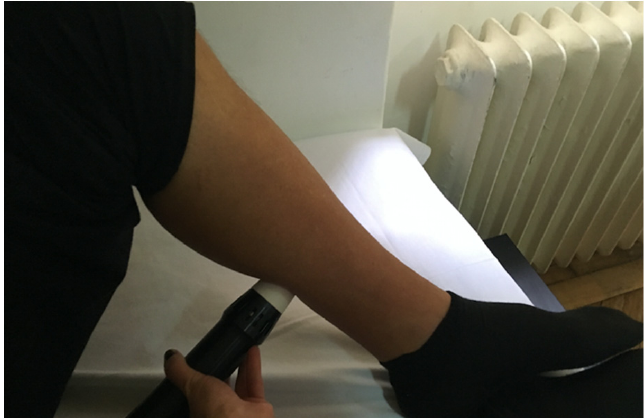
Figure 1. Radial extracorporeal shock wave therapy delivery on a patient from the clinical trial; original picture taken by the author EE Mihai in the Department of Physical and Rehabilitation Medicine, Elias University Emergency Hospital, Bucharest, using a digital camera (Nikon D3300; Nikon Corporation, Tokyo, Japan).